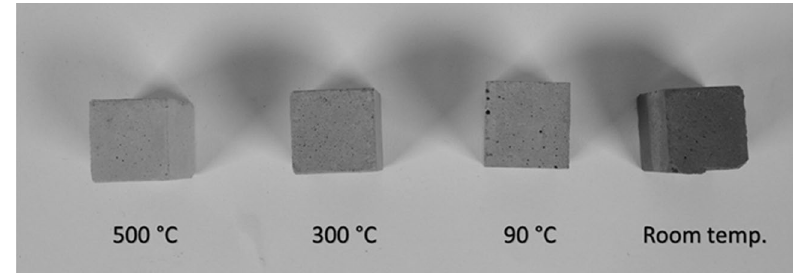
Fig. 11 Images of MK9_20 pastes before and after expo- sure to elevated temperatures (90, 300 and 500